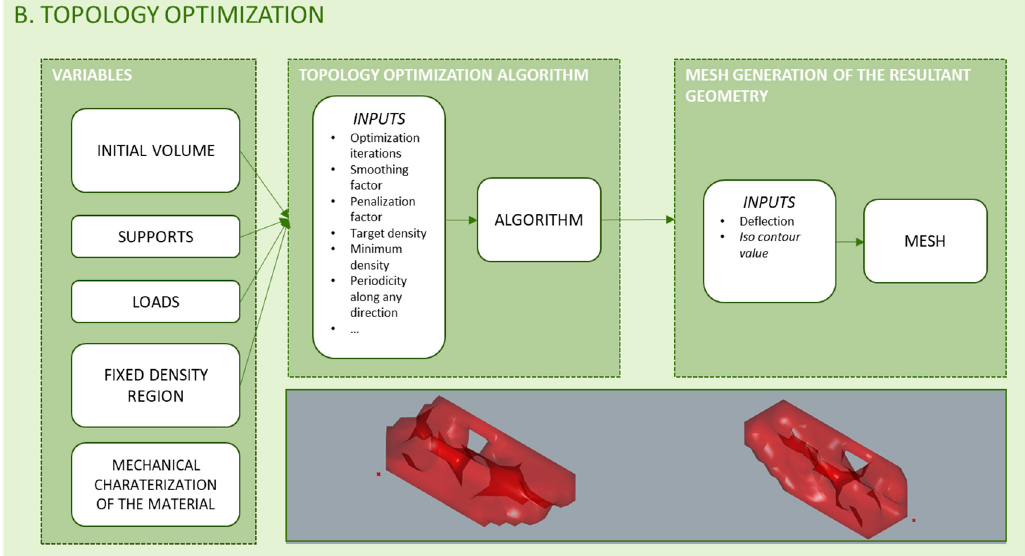
Figure 9. Programming structure for topology optimization.